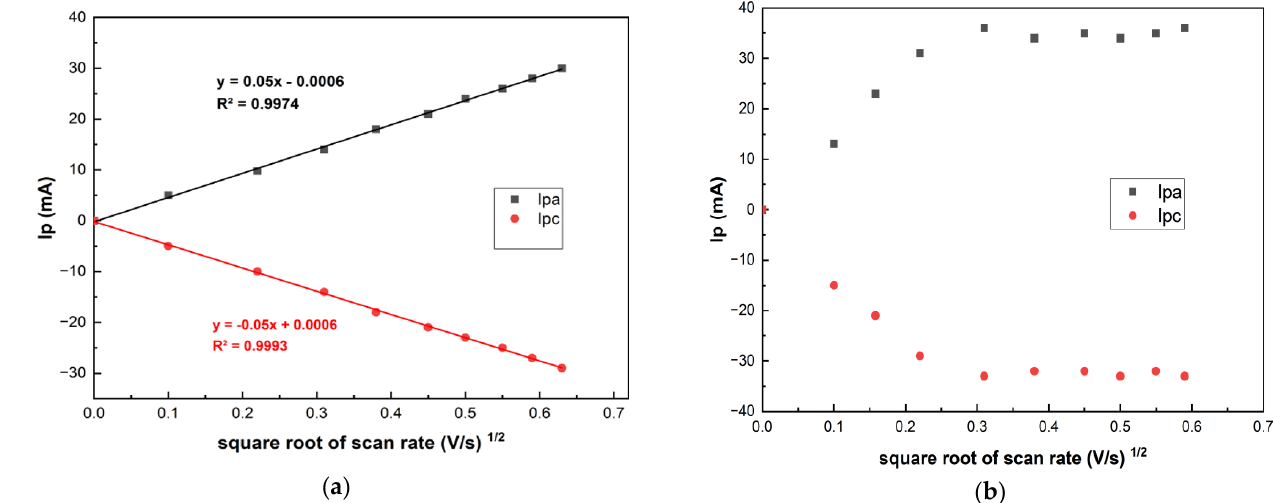
Figure 4. The dependences of the CV redox peak currents of 0.01 mol/L [Fe(CN) 6 ] 3 − /4 − in 0.1 mol/L KCI on the square root of scan rate on LRGO planar ( a ) and LRGO grid ( b ) electrodes.